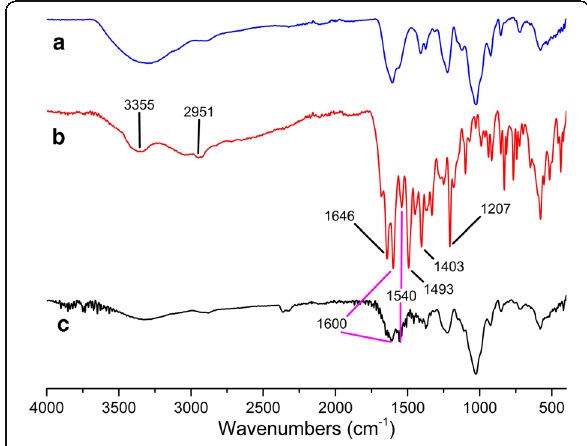
Fig. 1 a FTIR spectrum of CS. b FTIR spectrum of MTX. c FTIR spectrum of